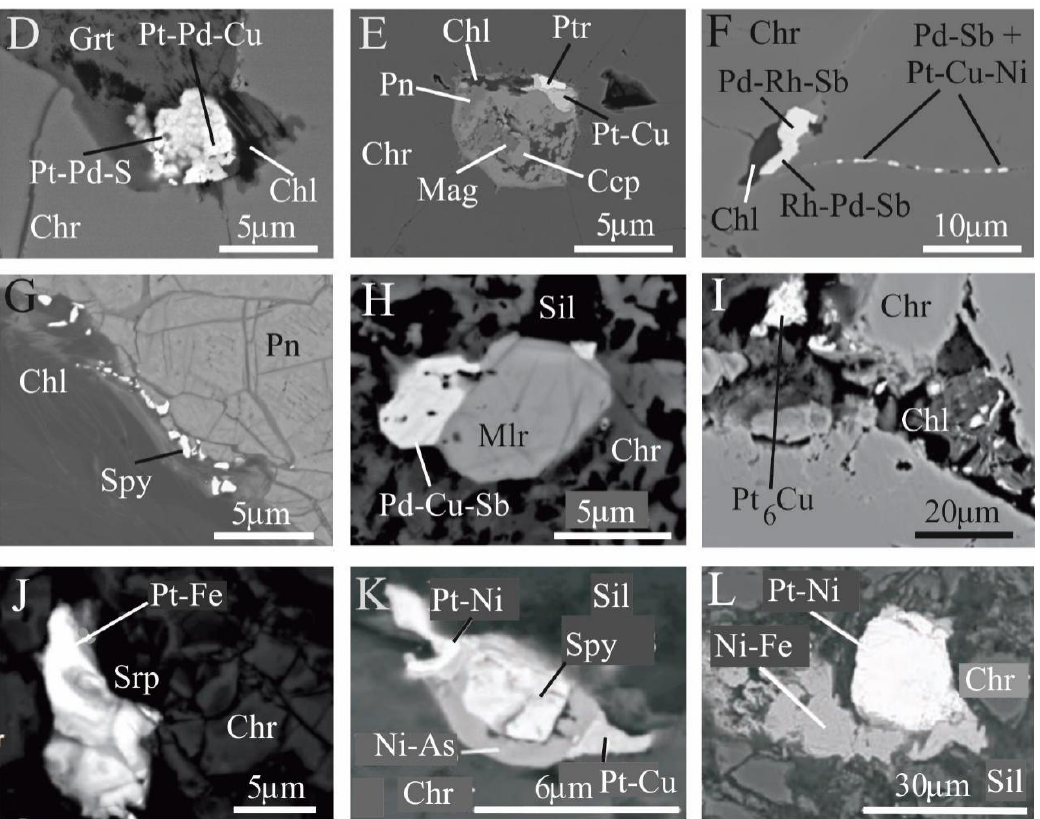
Figure 5. Back-scattered electron images of PPGM from selected the PPGE-rich ophiolitic chromitites. ( A ) Composite and polygonal inclusion of Pt-Fe alloy, and silicate pyrrhotite in unaltered chromite from Nurali [51]; ( B ) grain composed of osmium and Pt-Fe alloy in contact with chlorite and chromite from Loma Peguera [21]; ( C ) Pt-Fe alloy found in the chromitite of Sebuku showing a porous texture, irregular shape and zoning, in the contact of chromite and chlorite [59]; ( D ) secondary PGM of Pt-Pd-Cu and Pt-Pd sulfide associated with garnet and chlorite in altered chromite of Nurali [51]; ( E ) composite grain consisting of potarite, Pt-Cu alloy, pentlandite, chalcopyrite, magnetite and chlorite, in altered chromite of Nurali [51]; ( F ) altered PGM in contact with chlorite from the Newfoundland chromitites [26]; ( G ) irregular and tiny grains of sperrylite in the contact between chlorite and pentlandite in the Moa Baracoa chromitites [29]; ( H ) antimonide of Pd and Cu associated with millerite in contact with altered chromite and silicate of Al‘Ays chromitite [50]; ( I ) secondary Pt 6 Cu alloy in the altered matrix of Al‘Ays chromitite [50]; ( J ) Pt-Fe alloy in contact with serpentine found in the Korydallos chromitite [47]; ( K) complex grain composed of Pt-Ni, Pt-Cu alloys, sperrylite and Ni-arsenide associated with chromite and altered silicate, Korydallos chromitite [45]; ( L ) secondary Pt-Ni alloy in contact with Ni-Fe alloy in the altered matrix on the Korydallos chromitite [45]. Abbreviation: Sil = silicates, Chr = chromite, Pn = pentlandite, Pt-Fe = Pt,Fe alloys, Chl = chlorite, Os = osmium, Grt = garnet, Pt-Pd-S = Pt,Pd sulfide, Pt-Pd-Cu = Pt,Pd,Cu alloy, Ptr = potarite, Pt-Cu = Pt,Cu alloy, Ccp = chalcopyrite, Mag = magnetite, Pd-Sb = Pd antimonide, Pd-Rh-Sb = Pd,Rh antimonide, Rh-Pd-Sb = Rh,Pd antimonide, Pt-Cu-Ni = Pt,Cu,Ni alloy, Spy = sperrylite, Pd-Cu-Sb = Pd,Cu antimonide, Mlr = millerite, Srp = serpentine, Ni-As = Ni arsenide, Pt-Ni = Pt,Ni alloy, Pt-Cu = Pt,Cu alloy, Ni-Fe = Ni,Fe